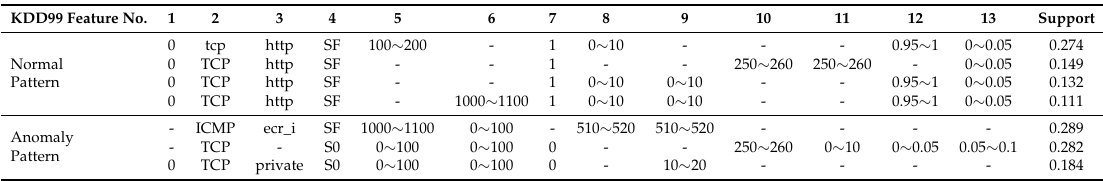
Table 7. Network patterns of